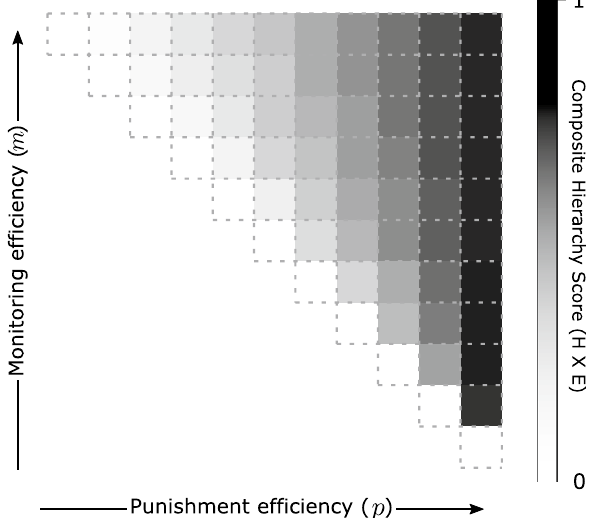
Figure 6. Composite hierarchy scores for the 12-node networks graphs in Fig. 5 show that, similar to the six-node networks in Fig. 4, greater monitoring and punishment efficiency corresponds with higher graph efficiency and graph hierarchy. Some parameter values had socially efficient graphs with greater composite scores. The graphs shown here are the median network hierarchy score from 1 million randomly generated networks. Versions of this plot with both component scores and with the lowest and highest hierarchy scores are in Appendix